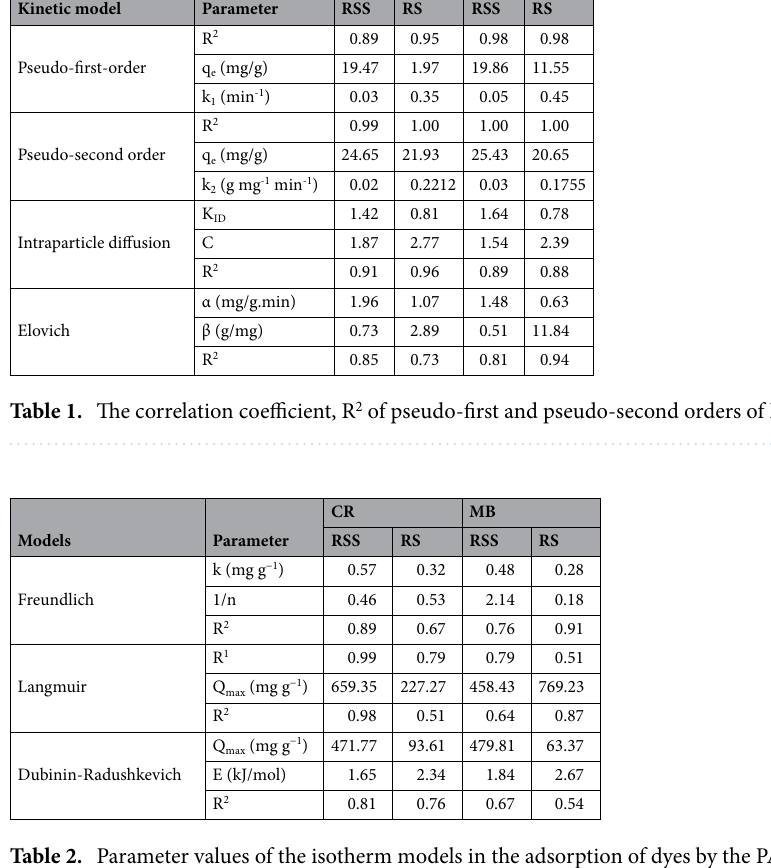
Table 2. Parameter values of the isotherm models in the adsorption of dyes by the PAC adsorbent.